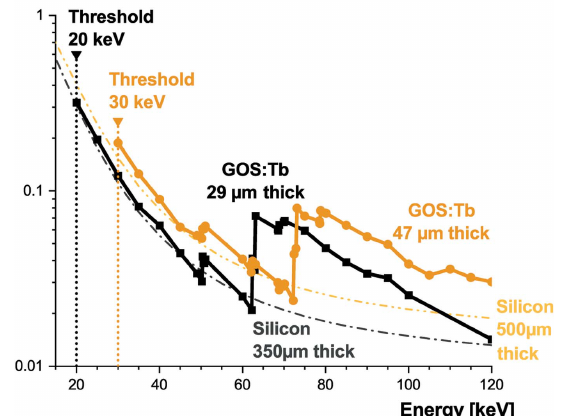
Figure 17 Detection efficiency with single X-ray photon discrimination for GOS:Tb powder screens based on Geant4 simulation (10000 events per energy). To exclude out-of-pixel interactions due to fluorescence from the gadolinium as well as Compton scattering, the interaction region is limited to 50 m m (cid:2) 50 m m. According to Section 3.3, the applied energy thresholds allow single X-ray photons to be detected with our detection scheme. The absorption efficiencies of silicon-based direct detectors (Berger et al. , 2010) are provided for comparison.